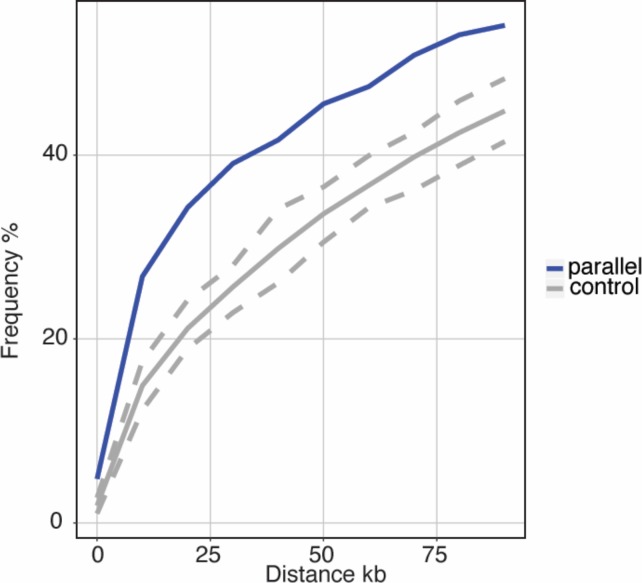
Transcripts with parallel expression divergence are in close spatial proximity to regions of the genome that show elevated parallel genetic divergence (CSS outlier loci) among marine and freshwater fish from the River Tyne and Little Campbell that were genome sequenced in this study.